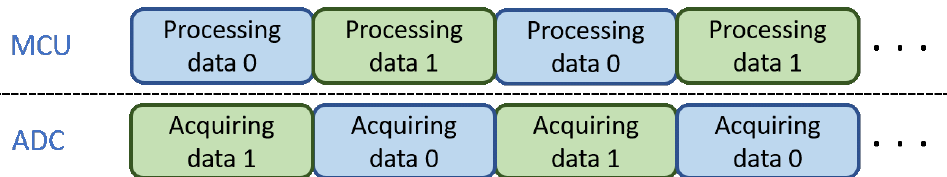
Figure 6. Improved time graph with the ping-pong buffer.